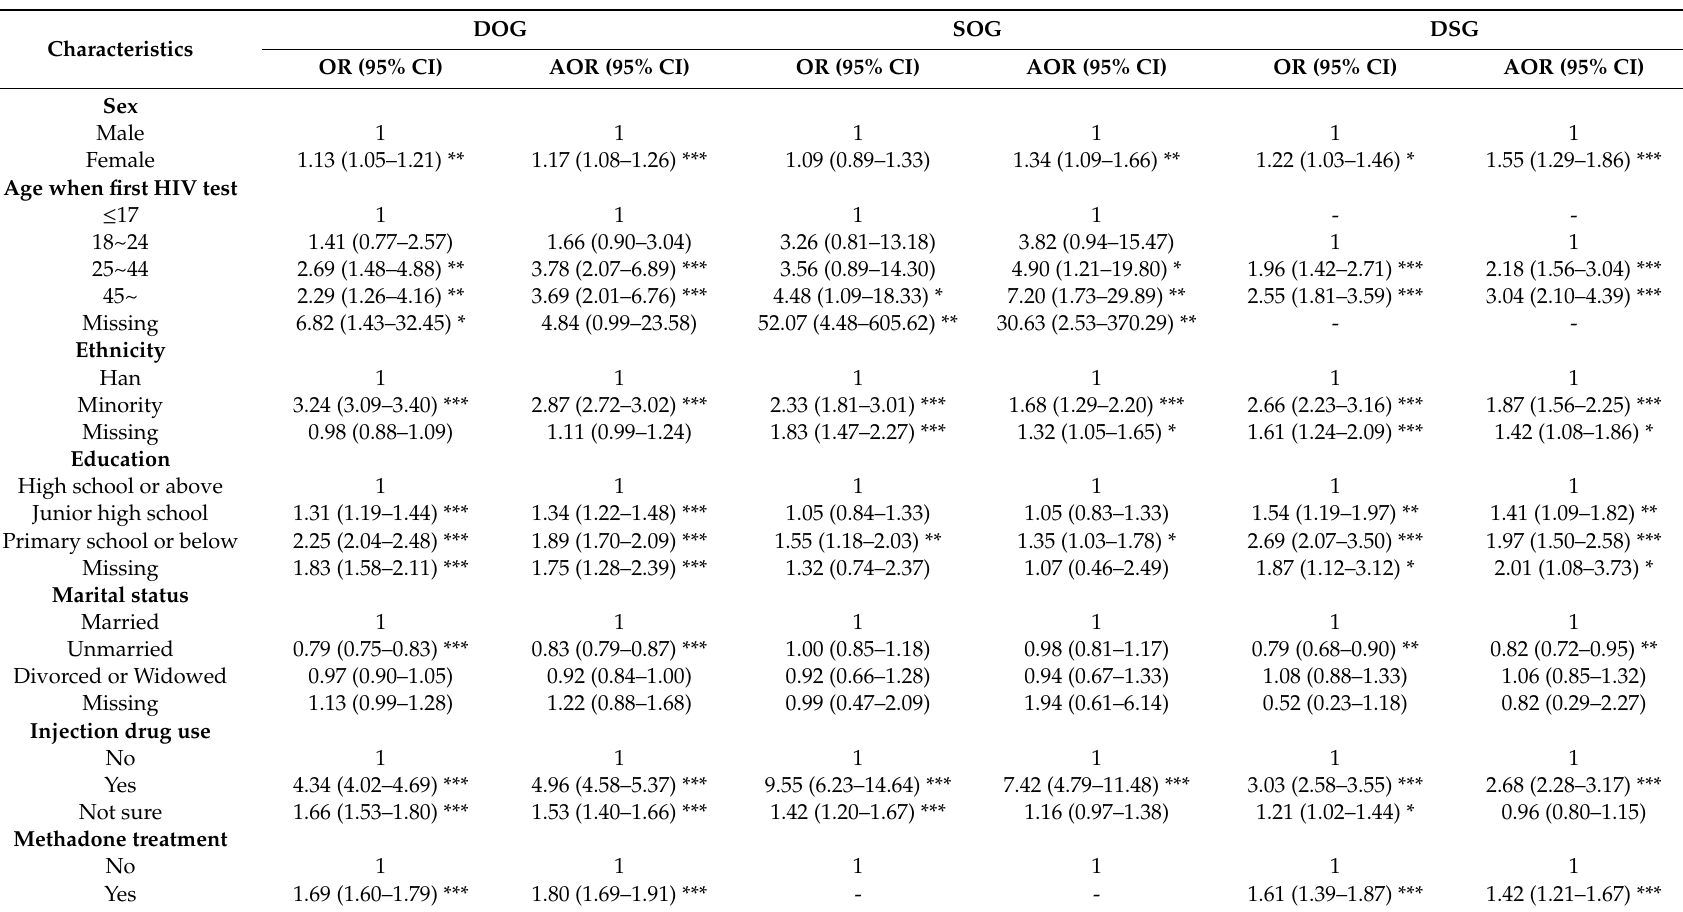
Table 3. Associated characteristics of HIV infection among depressants only, stimulants only and both depressants and stimulants users.